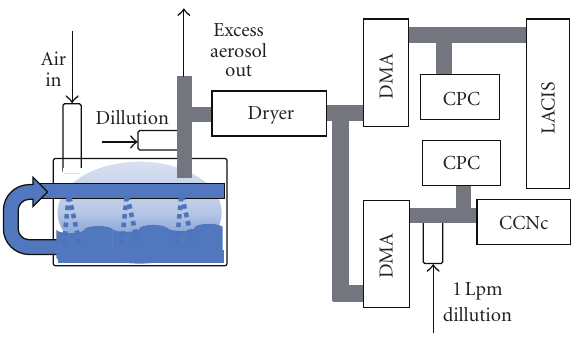
Figure 1: Sketch of the experimental